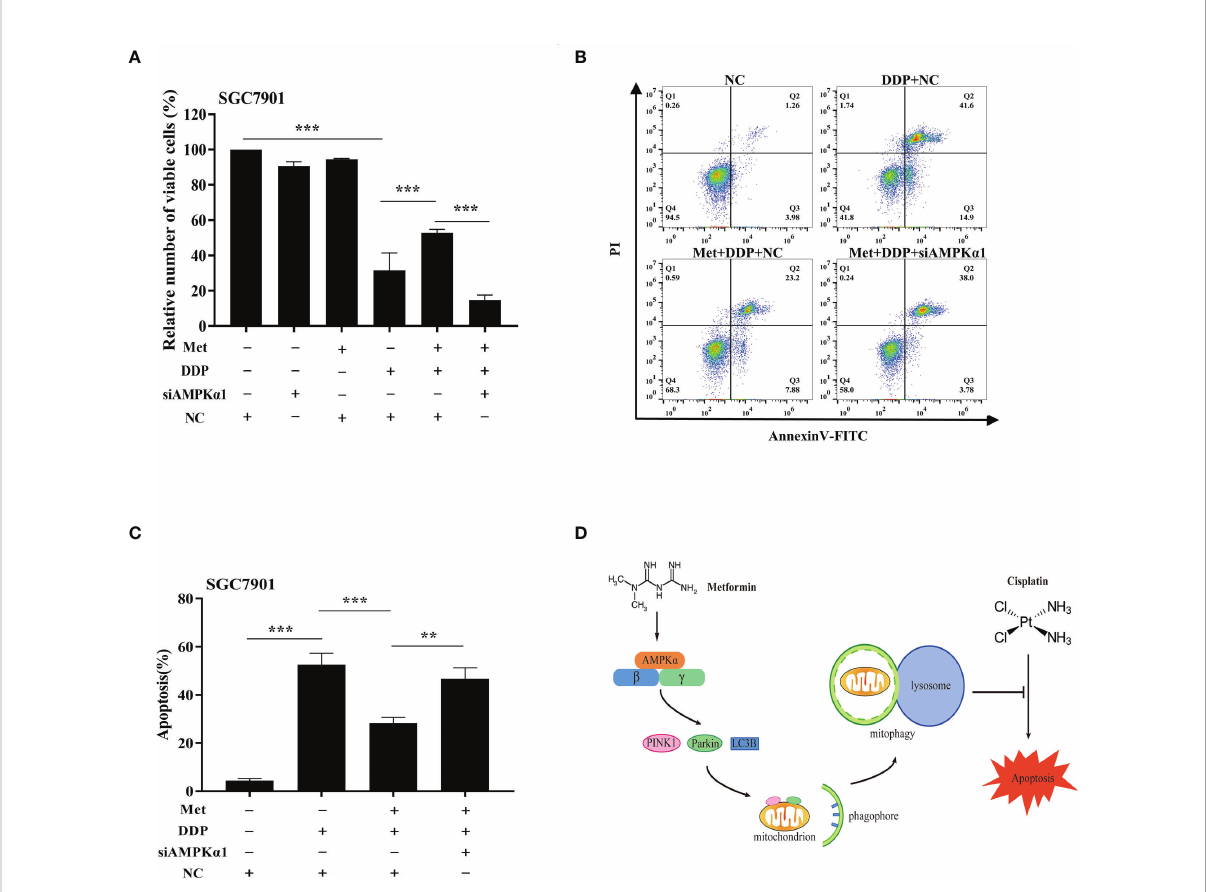
FIGURE 8 AMPK was involved in the metformin-induced mitophagy in GC cells. (A) SGC7901 cells were transfected with AMPK siRNA#2 or scramble siRNA (NC) for 24 h. Then, cells were pre-treated with 10 mM metformin followed by co-treating with 5 µg/mL cisplatin for 24 h. Cell viability was detected by CCK8 kit. (B, C) SGC7901 cells were transfected with scramble siRNA (NC) or AMPK siRNA#2 for 24 h. Then, cells were pre- treated with 10 mM metformin followed by co-treating with 5 µg/mL cisplatin for 24 h. Cell apoptosis was analyzed by Annexin V/PI staining. Bar diagram represents percentage of apoptotic cells. Data were presented as the means ± SD. The experiments were repeated three times independently. ** p <0.01, *** p <0.001. (D) A working model depicting the mechanism of metformin-induced cisplatin resistance in GC